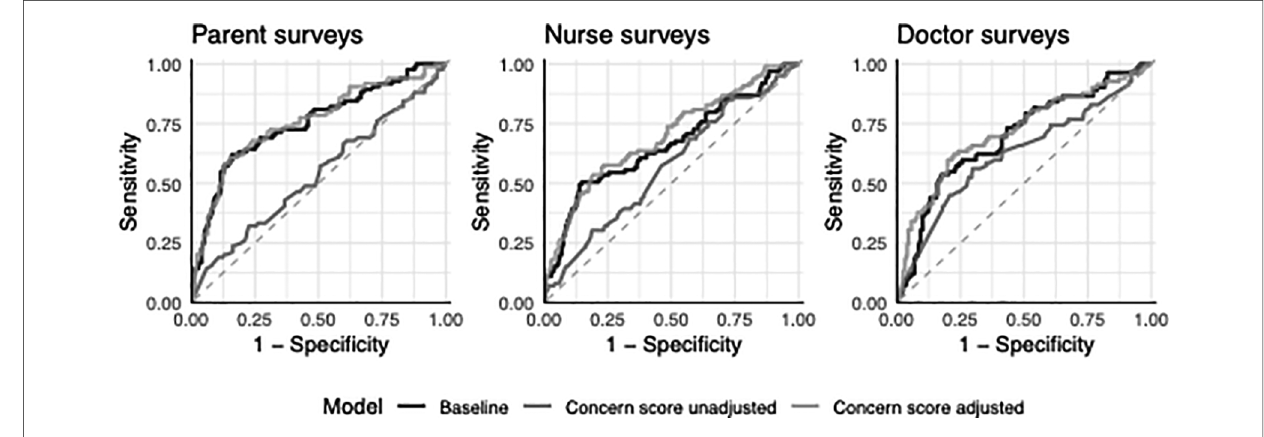
FIGURE 2 Diagnostic performance to predict sepsis on presentation for patients with parent, nurse, and doctor surveys.